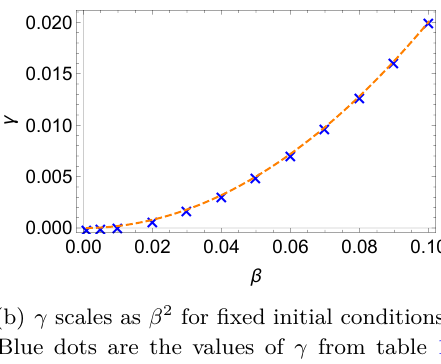
Blue dots are the values of α from table 1 for the corresponding β values in the table. Red dashed line is fitted function aβ 2 + b with